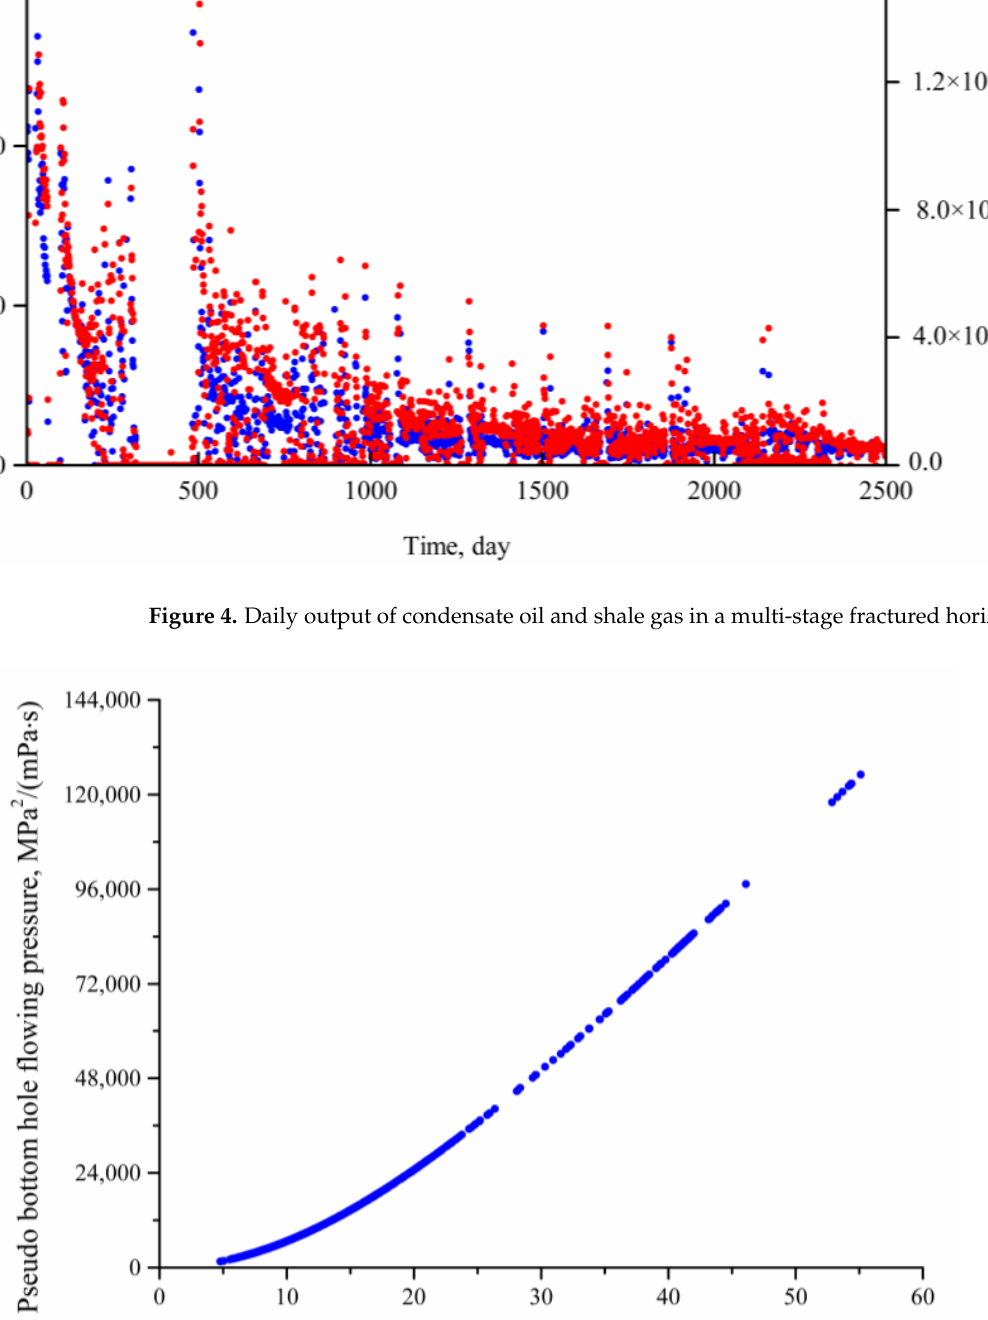
Figure 6. Bottom hole flowing pressure and CGR of the multi-stage fractured horizontal well. Figure 7. Equivalent gas production rate and pseudo bottom hole flowing pressure of the multi- stage fractured horizontal well.